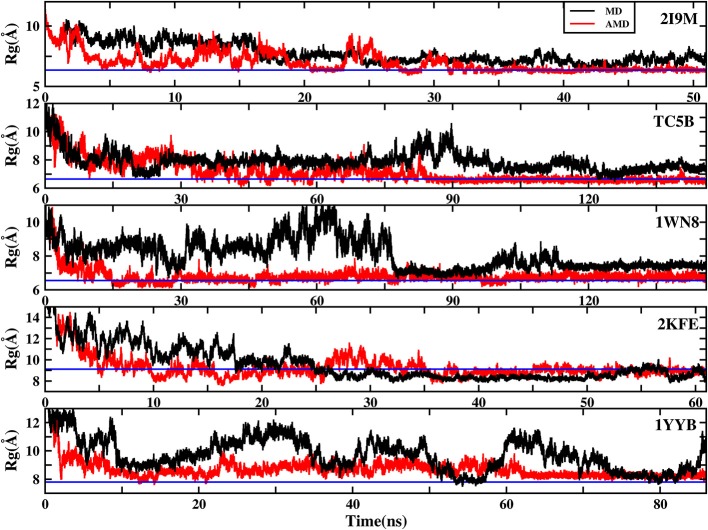
The radius of gyration (Rg) of the helix structure as a function of simulation time using the AMD simulation (red) and MD simulation (black) at 300 K for 2I9M, TC5B, 1WN8, 2KFE, and 1YYB, respectively. Blue lines denote those experimental values.